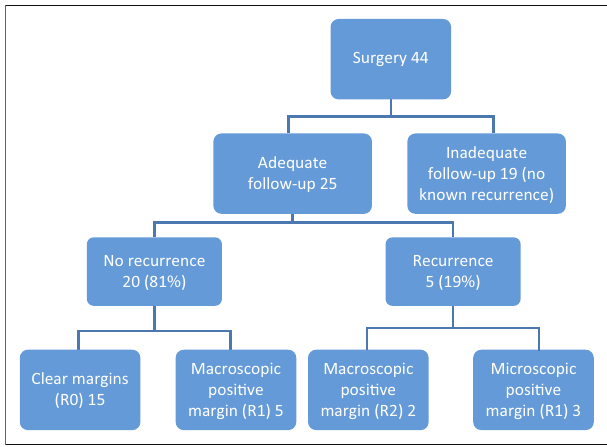
FIGURE 3: Outcome of surgical management.